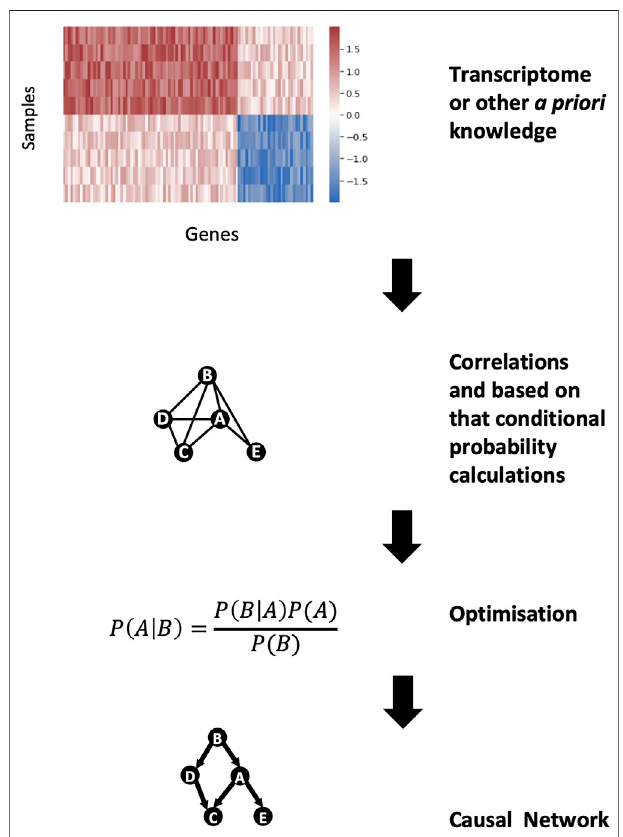
FIGURE 4 | Bayesian network construction for gene regulatory networks. From the high dimension of gene expression data, the correlations between genes can be calculated. These correlations can be modelled as conditional probabilities and, using the Bayes theorem, a casual gene regulatory network can be